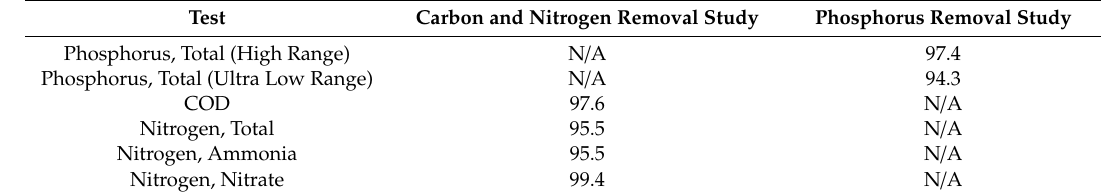
Table 7. Percent